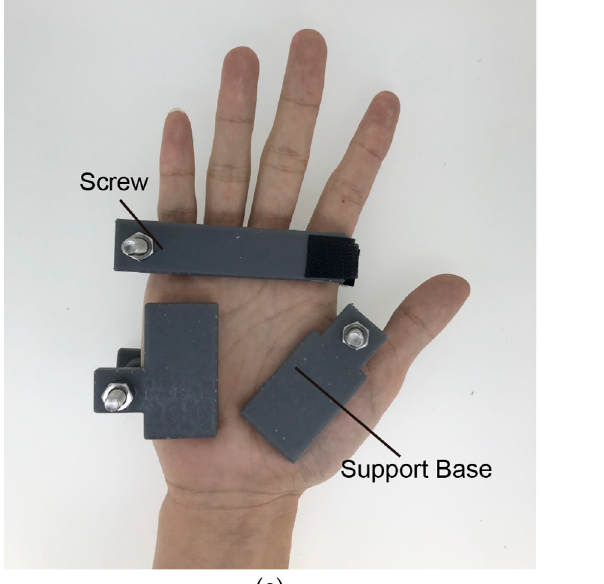
( b ) Figure 3. Mechanism of applying pressure onto palm with pouch actuators: ( a ) before heating and ( b ) after heating.